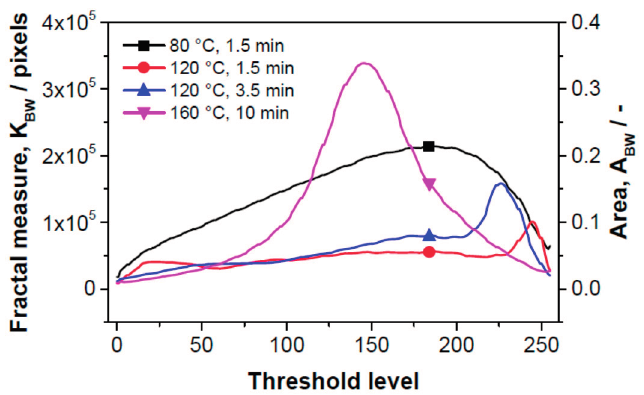
Figure 6. Dependence of the fractal measure of the surface between contour lines (threshold levels) on the magnitude of the threshold of gray scale images for sensors with differently thermally treated SPE